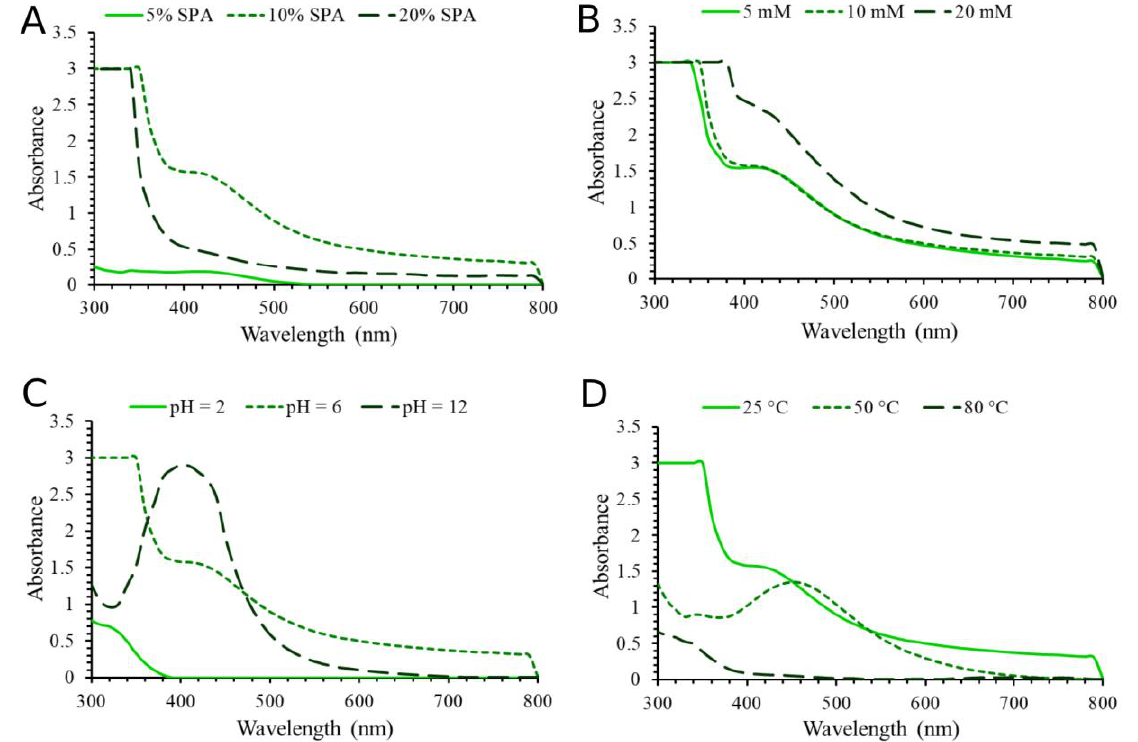
Figure 1. Influence of different parameters on the synthesis of SPA-AgNPs. ( A ) Extract concentrations, ( B ) AgNO 3 concentrations, ( C ) pH value, and ( D ) temperature.